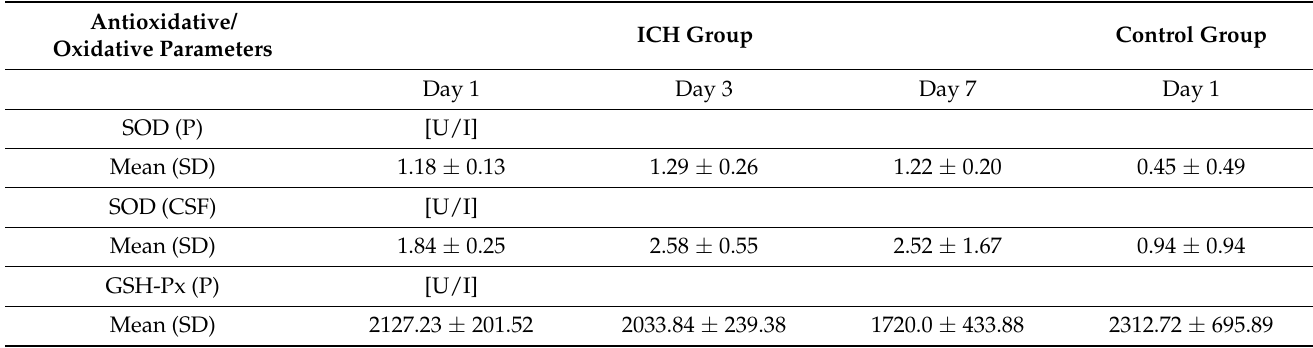
Table 2. Antioxidative/ Oxidative Parameters.